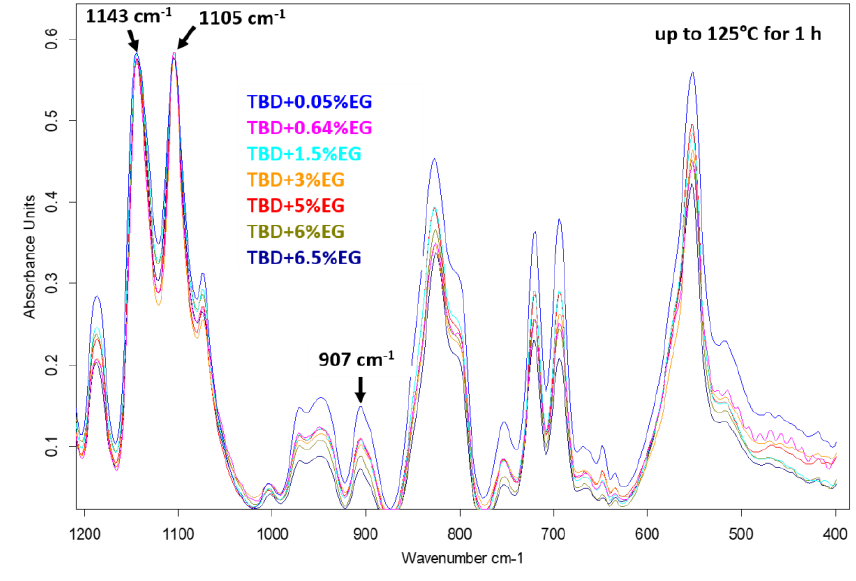
Figure 6. FTIR spectra of EG-based nanocomposites.